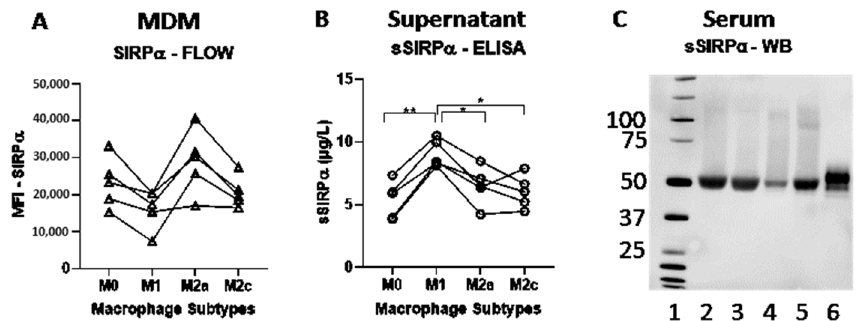
Figure 2. Expression and shedding of SIRP α . ( A ) Monocyte derived macrophages (M0) were po- larized into macrophage subtypes by LPS and IFN- γ (M1), IL-4 and IL13 (M2a), IL-10 (M2c) and the expression of SIRP α was investigated using flowcytometry. ( B ) Soluble SIRP α (sSIRP α ) was measured in the cell cultures by ELISA. (* p < 0.05, ** p < 0.01). ( C ) Western blotting of serum-samples from four individuals (Lane 2–5: samples, Lane 6: Recombinant extracellular SIRP α ). Table 2. sSIRP 𝛼 ELISA.